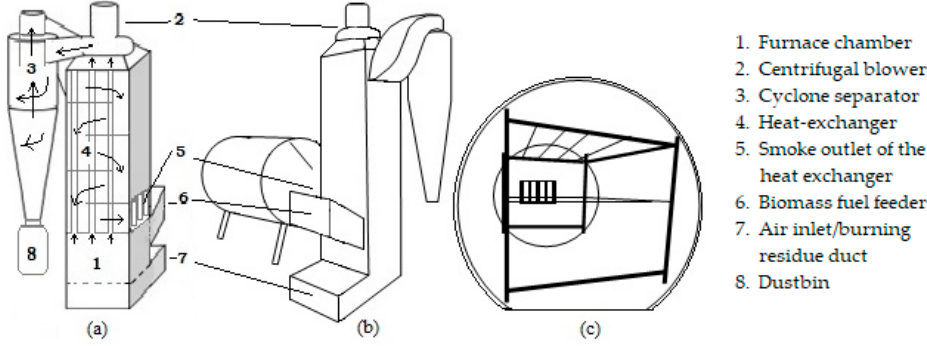
Figure 1. Smokehouse ( a ) schematic diagram of the smoke–heat generator; ( b ) integrated design; ( c ) the smoking